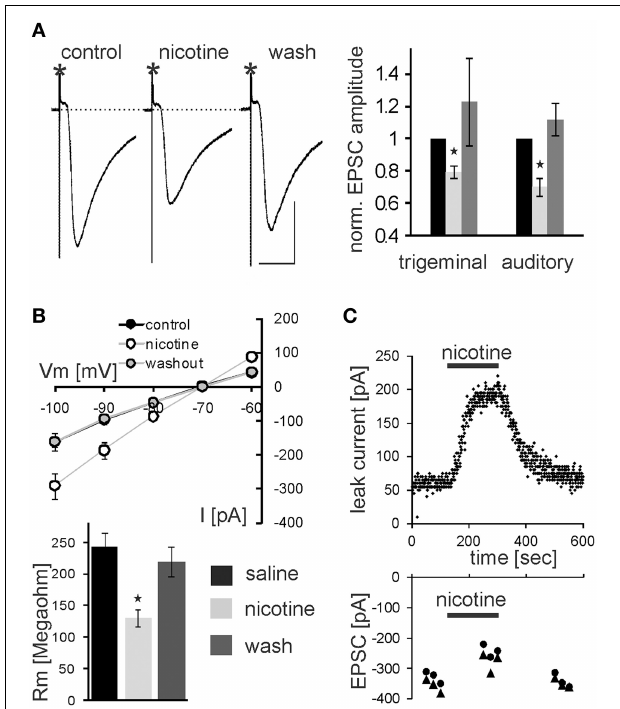
FIGURE 4 | Nicotine affects synaptic transmission and membrane resistance in PnC giant neurons. (A) Trigeminally evoked excitatory synaptic currents in control conditions, during perfusion with nicotine and after wash out. The asterisks mark the stimulus artifacts. Bars indicate 25ms (horizontal) and 100 pA (vertical). 10 μ M Nicotine significantly reduced EPSC amplitudes following trigeminal and auditory stimulation. This effect was reversed after wash out ( n = 14 cells). (B) Whole-cell membrane leak current amplitudes in response to 10mV step hyper- and depolarisations from − 70mV to the indicated potentials. Current amplitudes were increased during nicotine perfusion, indicating a lower membrane resistance (top) . Calculated membrane resistances ( Rm = (cid:3) Vm/ (cid:3) I) show that nicotine significantly reduces membrane resistance in PnC giant neurons (bottom) . (C) Time course showing whole-cell leak current amplitudes in response to a depolarizing 10mV voltage step from − 70mV in an exemplary cell before, during, and after nicotine bath application (top) , and the corresponding EPSC amplitudes in the same cell (bottom) .